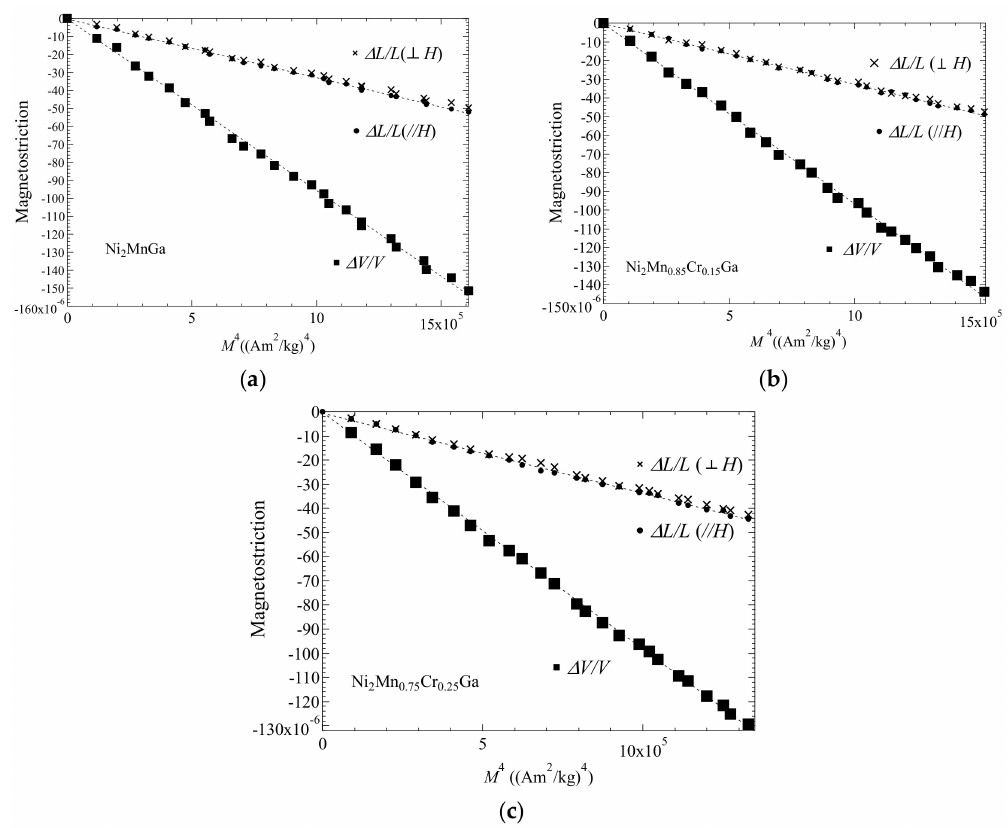
Figure 5. Forced magnetostriction for ( a ) x = 0.00, ( b ) x = 0.15, and ( c ) x = 0.25 at T c. The dotted straight line is the fitting line. The plots of ( ∆ L / L ) // and M 4 in ( a ) were obtained from Ref. [16]. T. Sakon et al. J. Appl. Phys. 2018 , 123 , 213902, with the permission of AIP Publishing. doi:10.1063 / 1.5036558. Title: “Forced magnetostriction of ferromagnetic Heusler alloy Ni 2 MnGa at the Curie temperature”. Available on line: https: // aip.scitation.org / doi / 10.1063 / 1.5036558 (accessed on 6 November